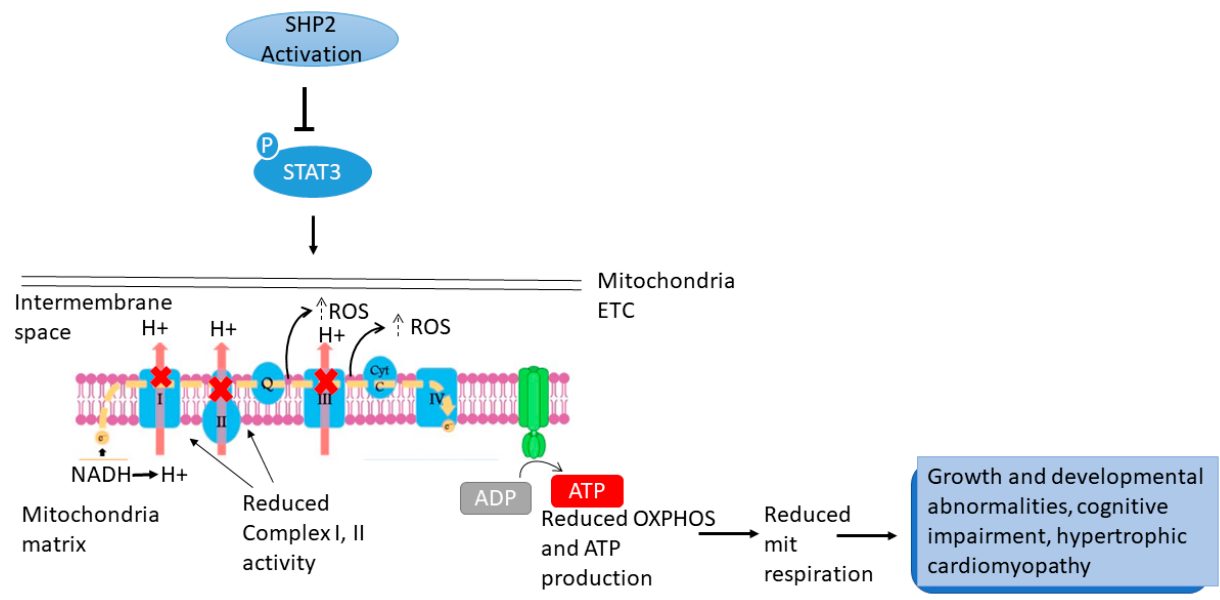
Figure 2. Activating SHP2 and Stat3 signalling in mitochondrial metabolism. Mutated SHP2 blocks Stat3 phosphorylation which inturn initiates a cascade of actions in the mitochondrial ETC. Reduced complex I, II activity results in deficient OXPHOS and ATP generation and is accompanied by increased ROS (upward dotted arrows), thus decreasing mitochondria respiration resulting in phenotypes observed in NS/NNSML.